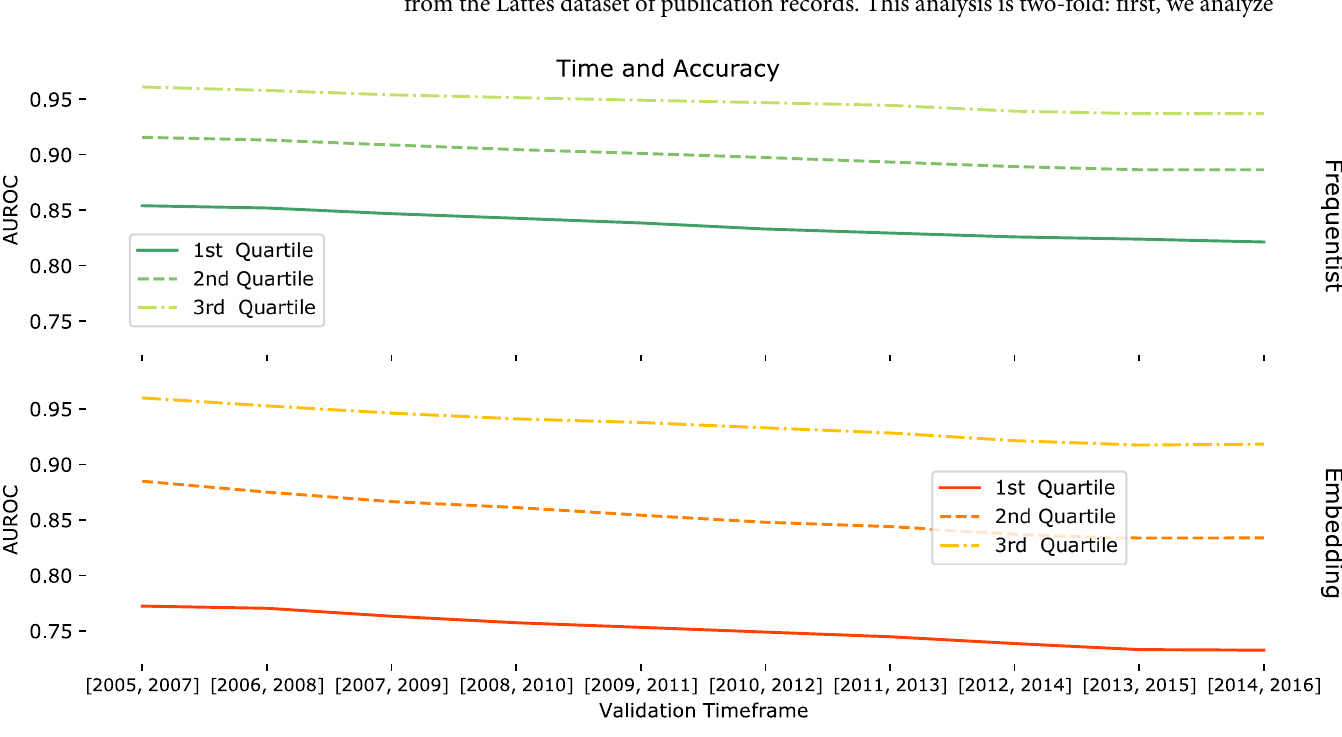
Fig 10. Long-term predictions. First, second and third quartiles of AUROC yielded by the Frequentist model for different prediction testing windows, when predicting the transition inactive to active for the 15,491 scientists that performed some transition in every window. Time windows for model fitting and density estimation are resp. [1990, 2004], [2002, 2004]. We consider all 3-year windows starting between 2005 and 2014 for testing the predictions.